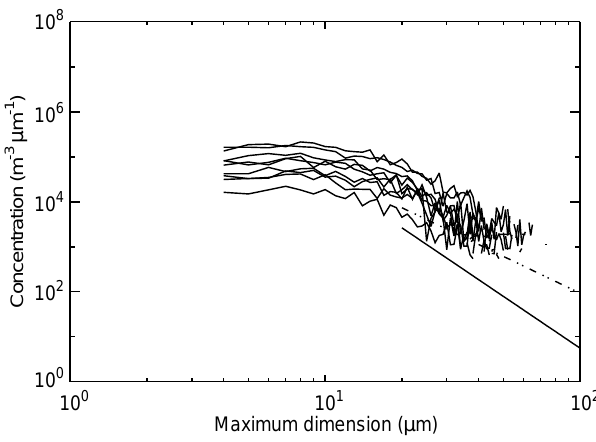
Fig. 3. Size distributions measured in aged contrails on 9 October 1992 over Southern Germany. Lines as in Fig. 2